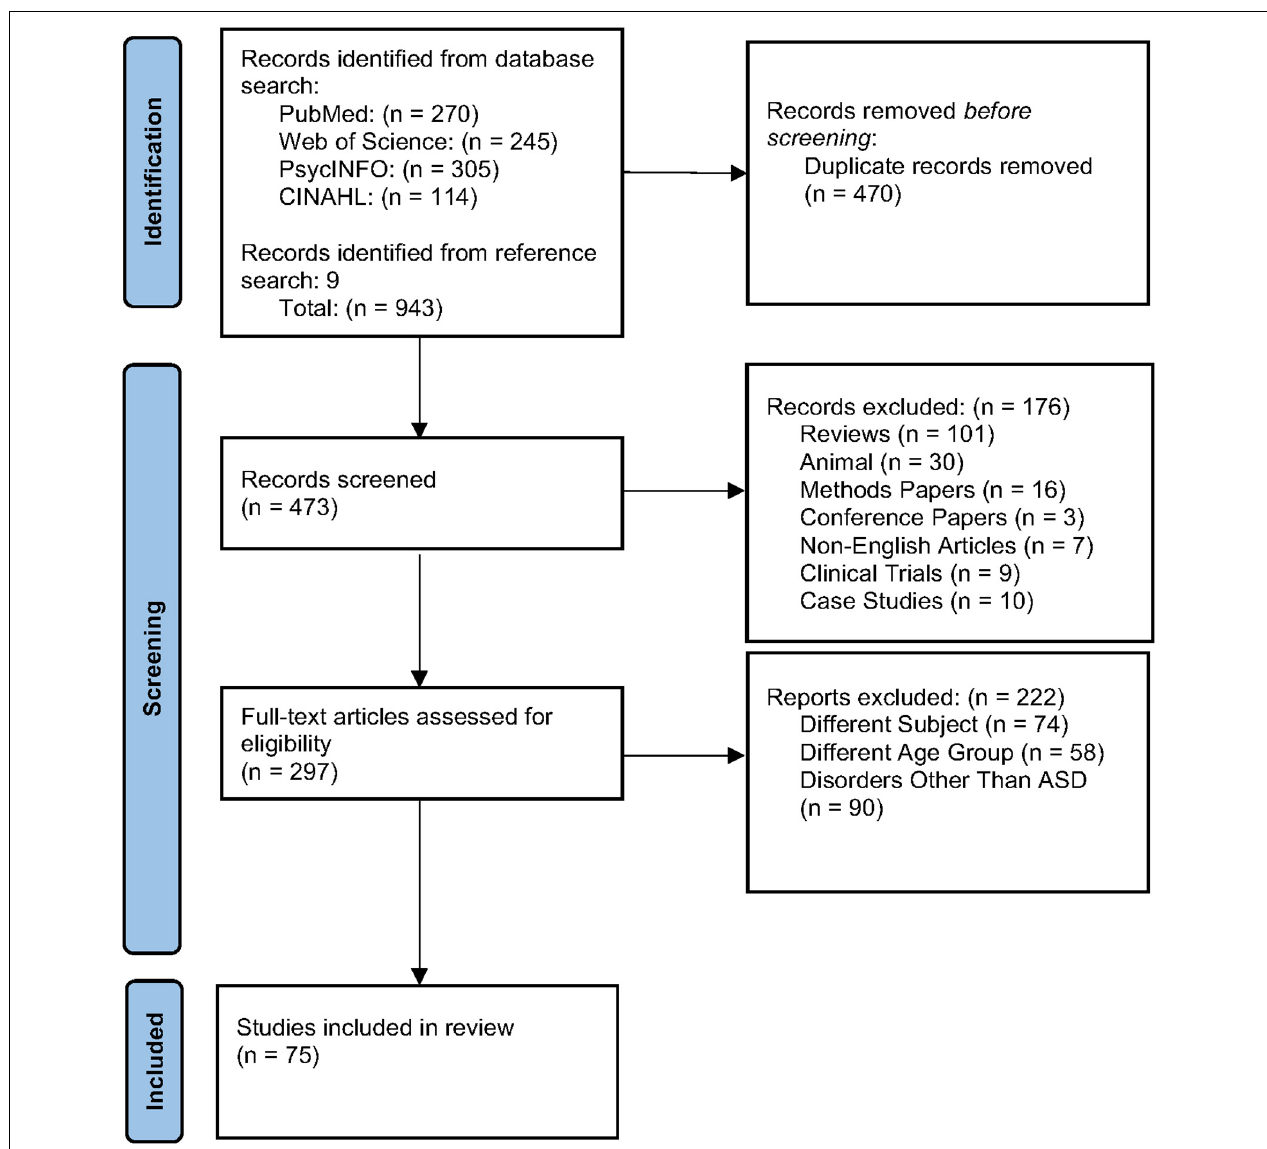
FIGURE 1 | PRISMA diagram of literature screening and